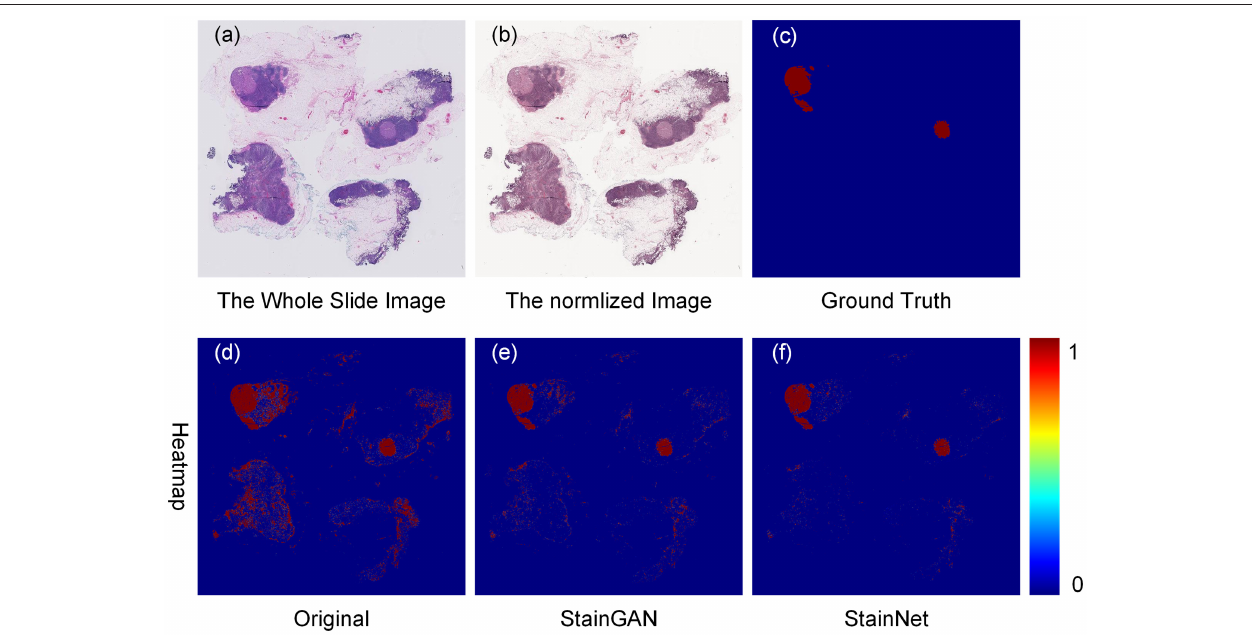
FIGURE 8 | Effects of color normalization on metastasis cancer tissue detection. The original whole slide image (a) , the normalized image by StainNet (b) , the ground truth (c) of the metastasis cancer, and the detection heat maps from the original image (d) , from the image by normalized StainGAN (e) , and from the image by normalized StainNet (f) .